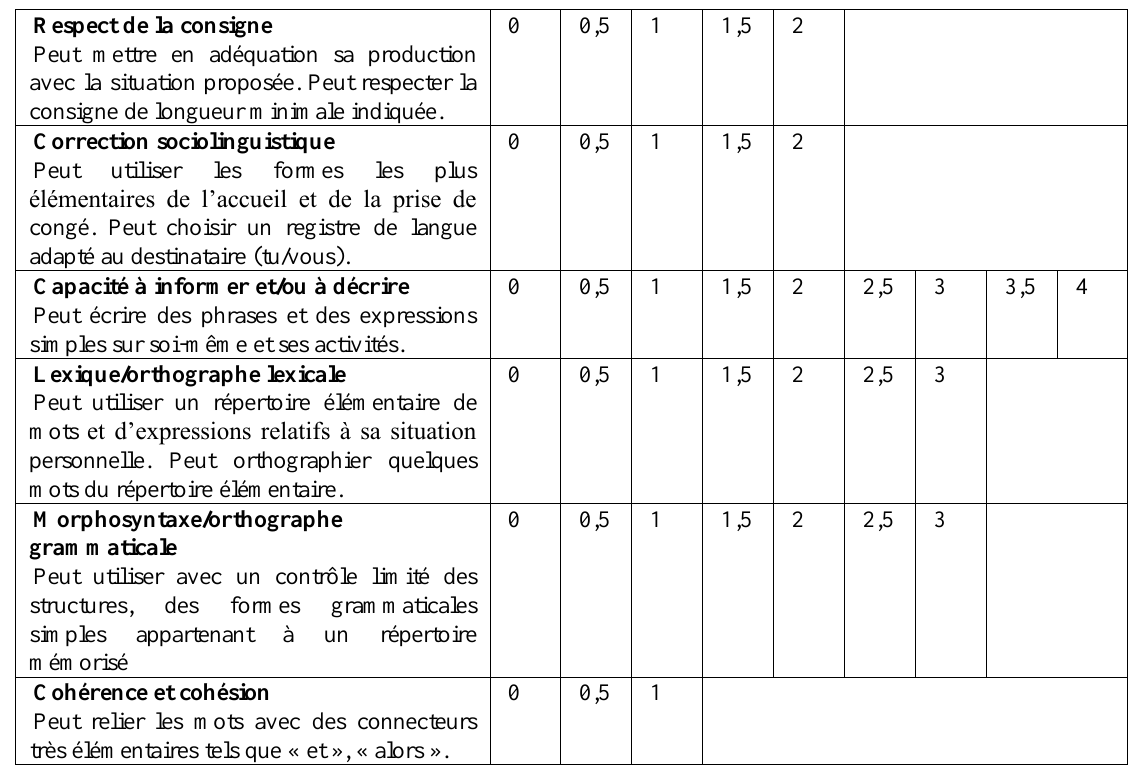
Tableu 1 L'évaluation de la production écrite du DELF A1 fournie par le